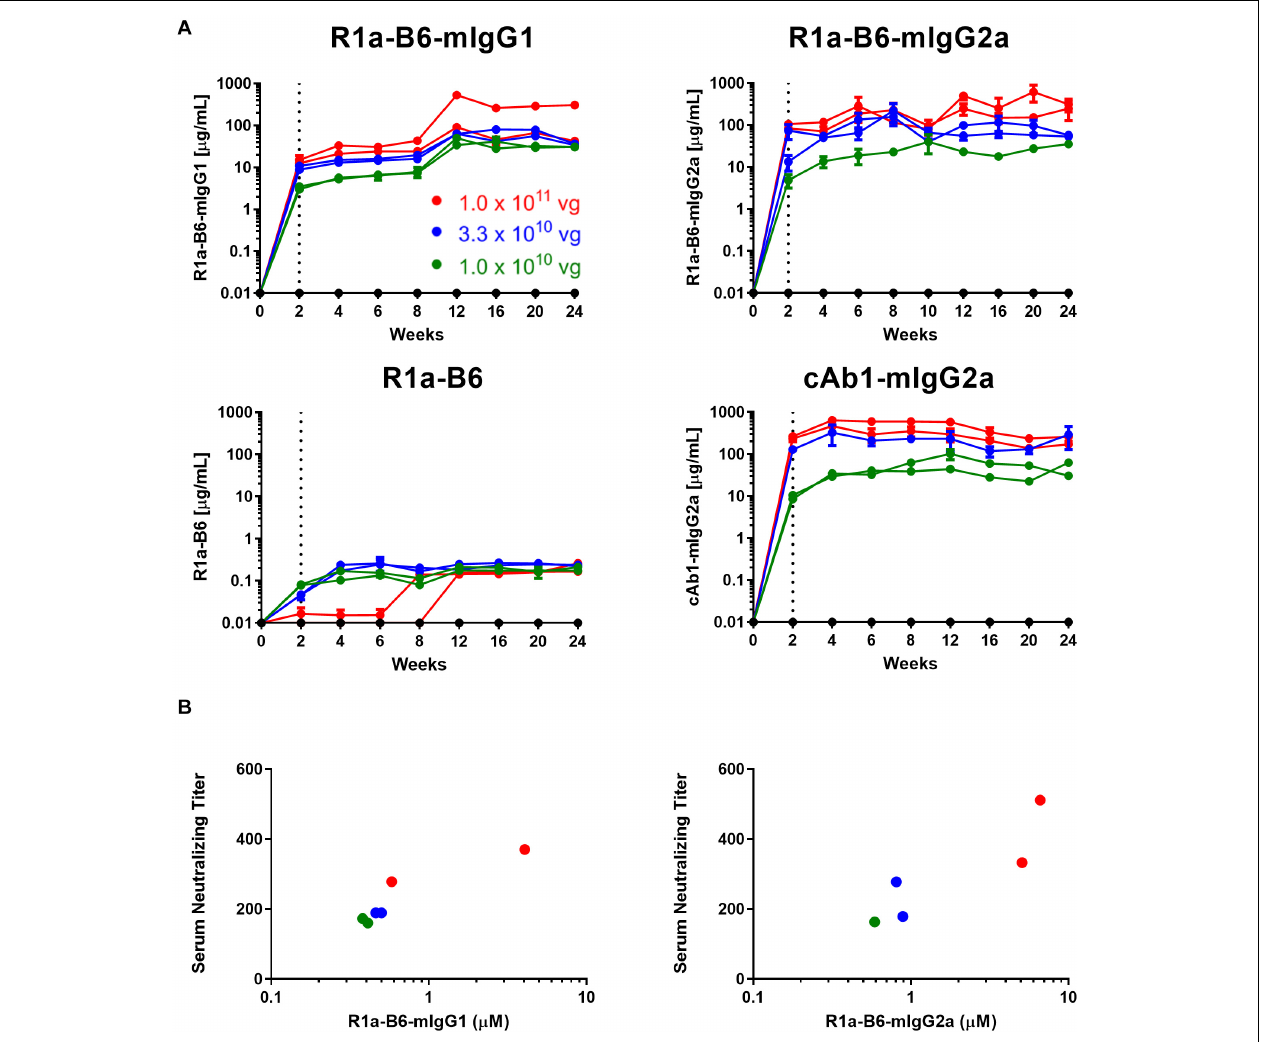
FIGURE 2 | AAV dose ranging study of anti-influenza neutralizing nanobody R1a-B6 in mice. (A) Different R1a-B6 constructs and the control nanobody, cAb1, were given via AAV in vector genome (vg) doses of 1.0 × 10 10 vg (green series), 3.3 × 10 10 vg (blue series), and 1.0 × 10 11 vg (red series). Mice that were given PBS are indicated by the black series. Nanobodies in serum of BALB/c mice were measured from week 0 to 24. A mouse given 1.0 × 10 10 vg of R1a-B6-mIgG2a was culled before the end of the study due to reasons exclusive of AAV delivery. Each individual series corresponds to a single mouse. The dotted line represents the point (2 weeks) at which nanobody expression levels were first detected. (B) Neutralizing activity of sera taken from mice 24 weeks after they were injected with different doses of AAV encoding R1a-B6-mIgG1 and R1a-B6-mIgG2a was measured against 10 3 TCID 50 /mL of CA/09. The serum neutralizing titer is expressed as the reciprocal of the highest dilution at which influenza infection is completely blocked. Mice given R1a-B6 (all doses) did not show any neutralizing activity (data not shown). For all plots, each point represents an individual mouse serum sample, n = 2